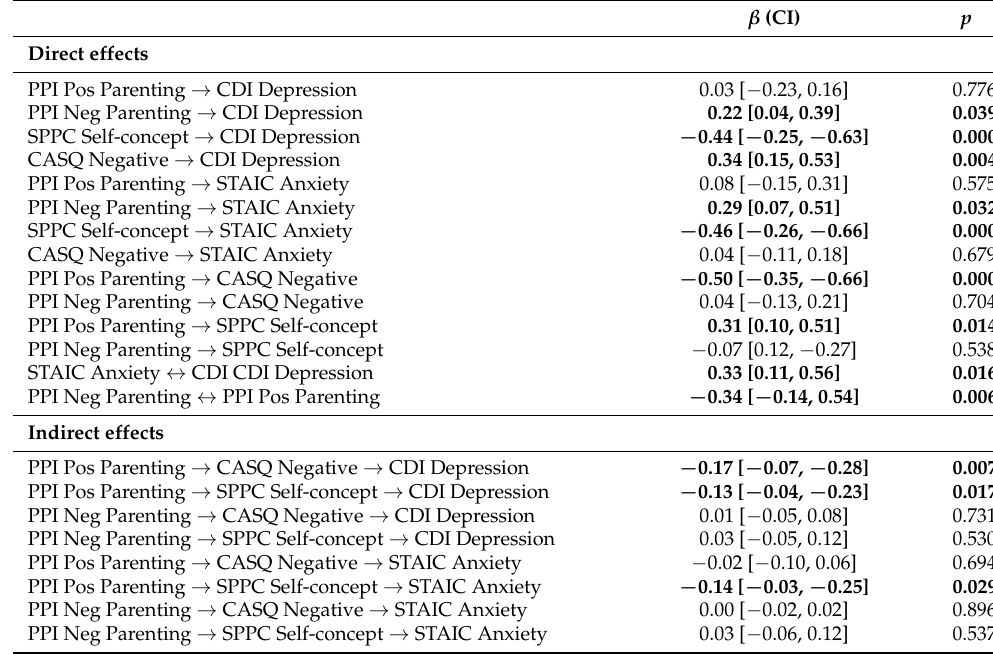
Table 2. Standardized direct and indirect path coefficients with confidence